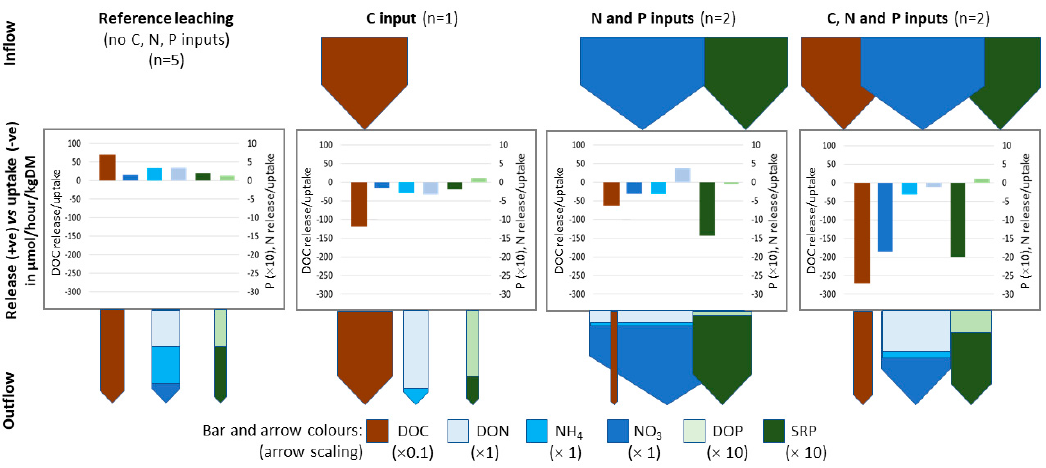
Figure 4. Overall summary, showing (i) inflow relative concentrations (upper arrow widths; treatment concentrations), (ii) gross cycling rates in the column (central bar charts by bar height; average µmol/h/kg DM where positive and negative bars denote release and uptake, respectively) and (iii) outflow relative concentrations (lower arrow widths; averaging final three column outflow samples). The arrow widths denote the inflow and outflow DOC, total dissolved N and P molar concentrations (at scaling C × 0.1, N forms × 1, P forms × 10) and the N and P speciation in the outflow arrows is proportional to the total arrow length. The leftmost column chart is the reference leaching cycling rate (µmol/h/kg DM) then the three rightmost charts are the gross cycling rates for C, NP and CNP treated columns. The gross rate comprises the net rates adjusted by the reference leaching rate (the incorporation of an internal nutrient source extrapolated from the background leaching). As one example we consider value derivation for the C treat . The reduction in DOC concentration between column in fl ow (upper wider brown arrow) and out fl ow (lower, narrower brown arrow) equals − 49 µmolC/h/kg DM net uptake (in the central bar chart), but considering the extrapolation of the background (sediment-derived) release of +70 µmolC/h/kg DM this becomes the − 119 µmolC/h/kg DM gross uptake depicted here. The C treat in fl ow contains no N or P, yet SRP shows − 2 µmolP/h/kg DM gross uptake. This is possible since all of the background +2 µmolP/h/kg DM SRP release is retained (even though no additional treatment P is added). A further example of this gross calculation effect is that the NP treat has − 63 µmolC/h/kg DM gross uptake indicative of the +70 µmolC/h/kg DM background (internal) DOC release, leaving a small DOC outflow concentration (approximating +7 µmolC/h/kg DM) when no C was added in the treatment. Values are derived from Table 1. In general, the addition of labile C reduced the leaching of most N and P forms from the sediments, resulting in a gross uptake of NO 3 -N and SRP when these nutrients were added. Labile C in the CNP treat increased gross uptake of both native and added NO 3 -N by 6 times compared to the NP treat , while gross uptake of SRP was enhanced only 1.5-fold. However, these C-induced effects were different when all inorganic and organic forms of N and P were considered. The enhanced leaching of DON in the NP treat , for example, countered the uptake of NO 3 -N there, leading to even greater differences in gross uptake of total N between the NP and the CNP treatment (subject to our caveats regarding DON analytical uncertainties). In contrast to N, the relatively small gross release of DOP minimally changed the positive effects of labile C addition on total P uptake. 3.4. Destructive Sediment Sampling Post-Column Treatments Although the number of treated column replicates was limited, the results of the destructive sampling are discussed generally in comparison to the background sediment that was not exposed